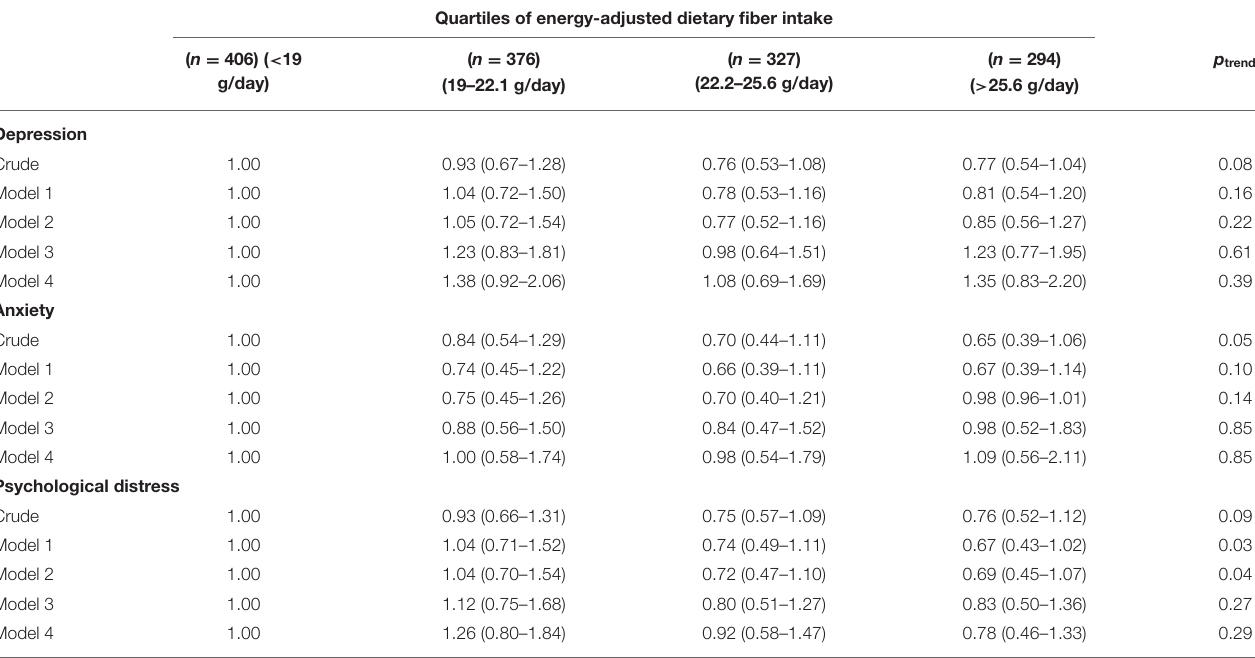
TABLE 4 | Multivariable-adjusted odds ratios and 95% confidence intervals for depression, anxiety, and psychological distress across quartiles of energy-adjusted dietary fiber intake in men ( n = 1,403) a . Quartiles of energy-adjusted dietary fiber intake